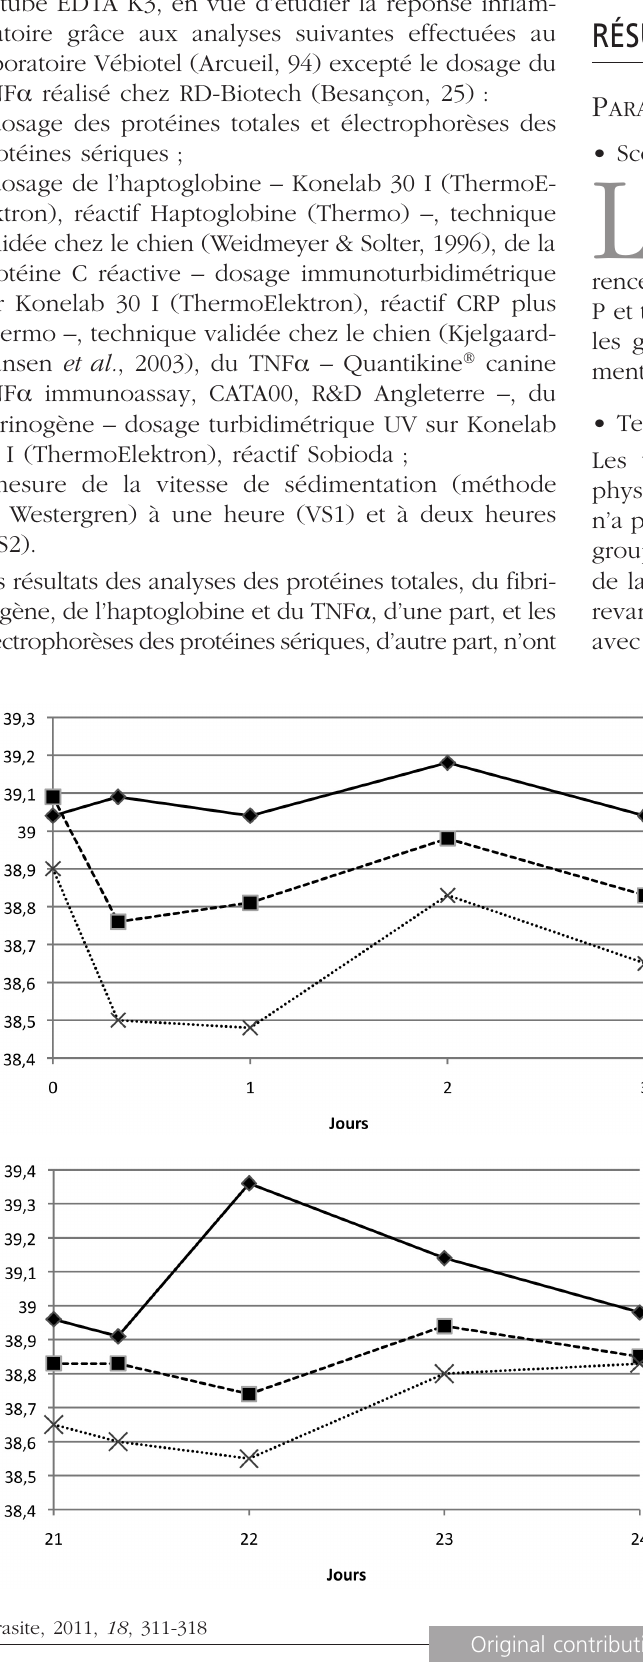
Figure 2. – Moyenne des tempéra- tures rectales (°C) suite à la seconde immunisation des groupes NP, P et